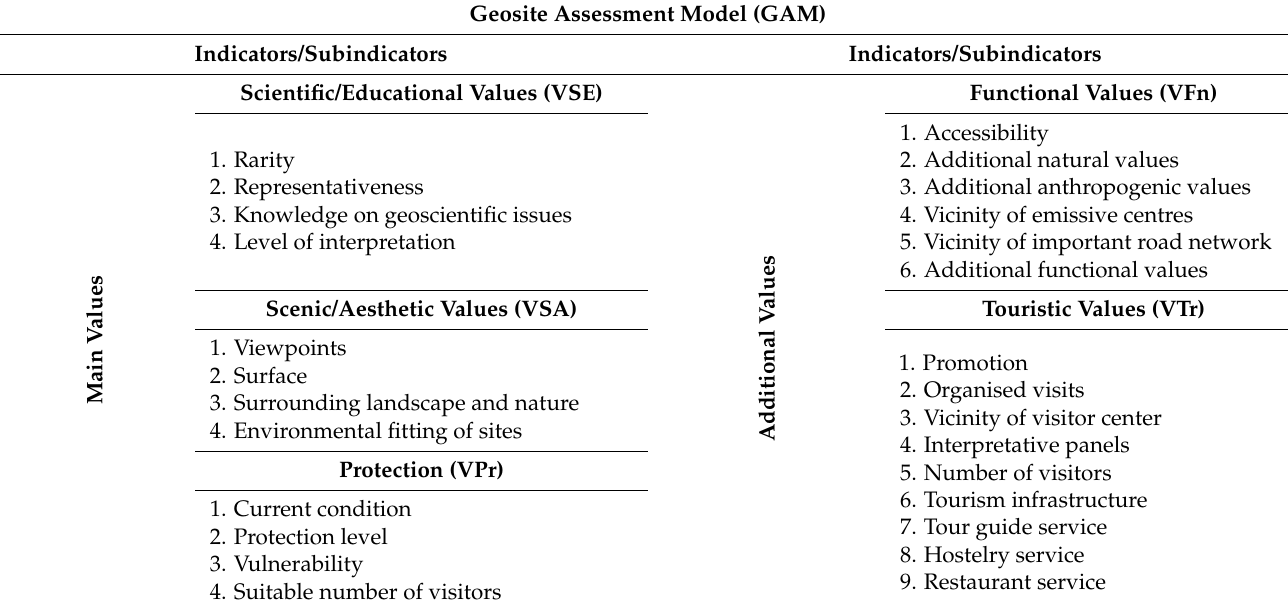
Table 1. The geosite assessment model (GAM) shows the main indicators of value and the indicators of additional value [64].